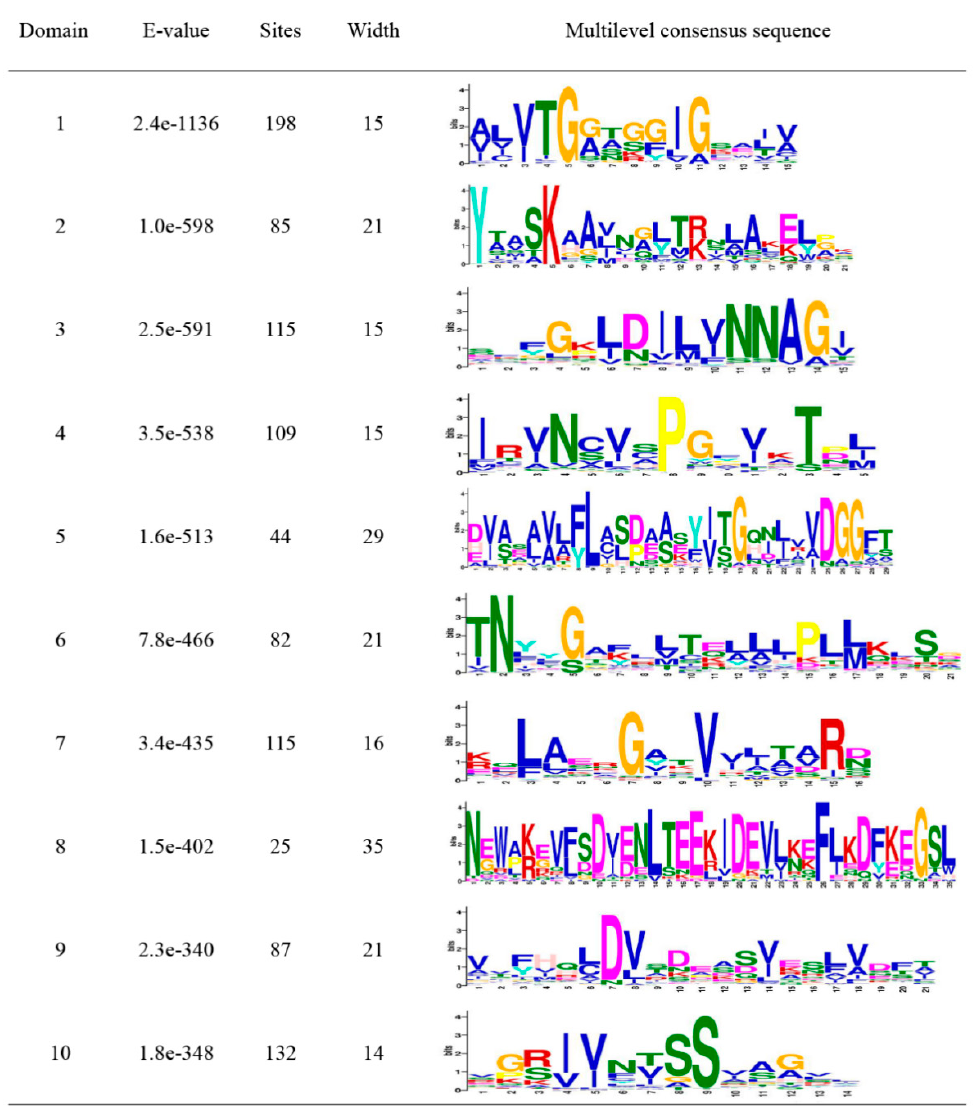
Figure 2. Details of Ten Motifs of MtSDRs.